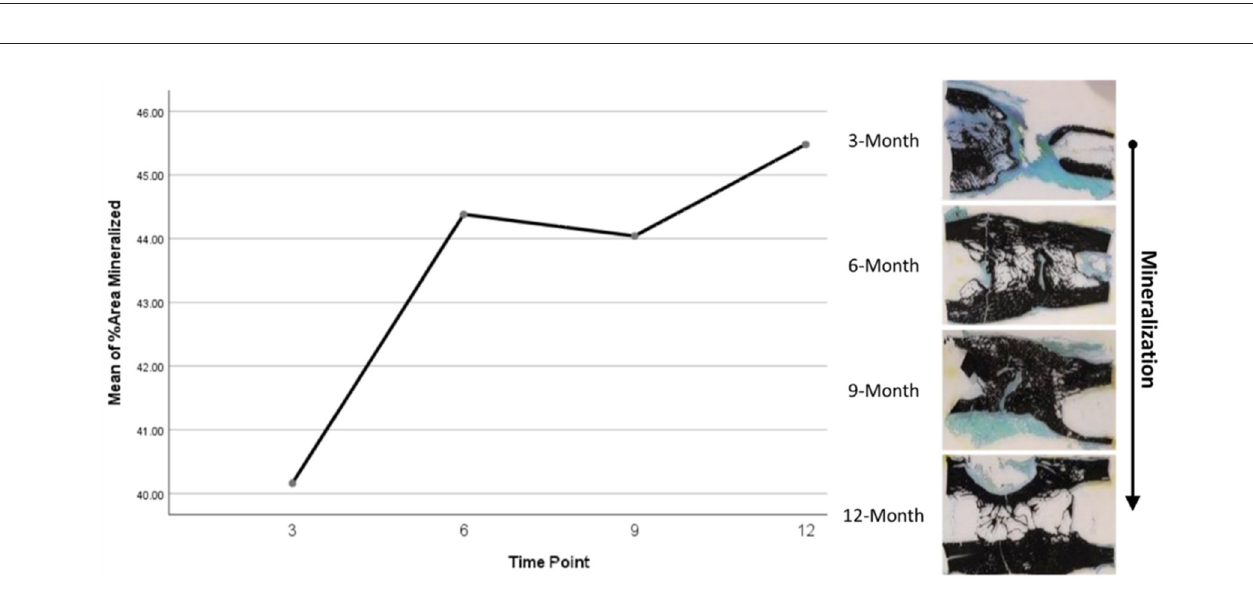
FIGURE5 Representative Von Kossa histological staining and plotted mineralization